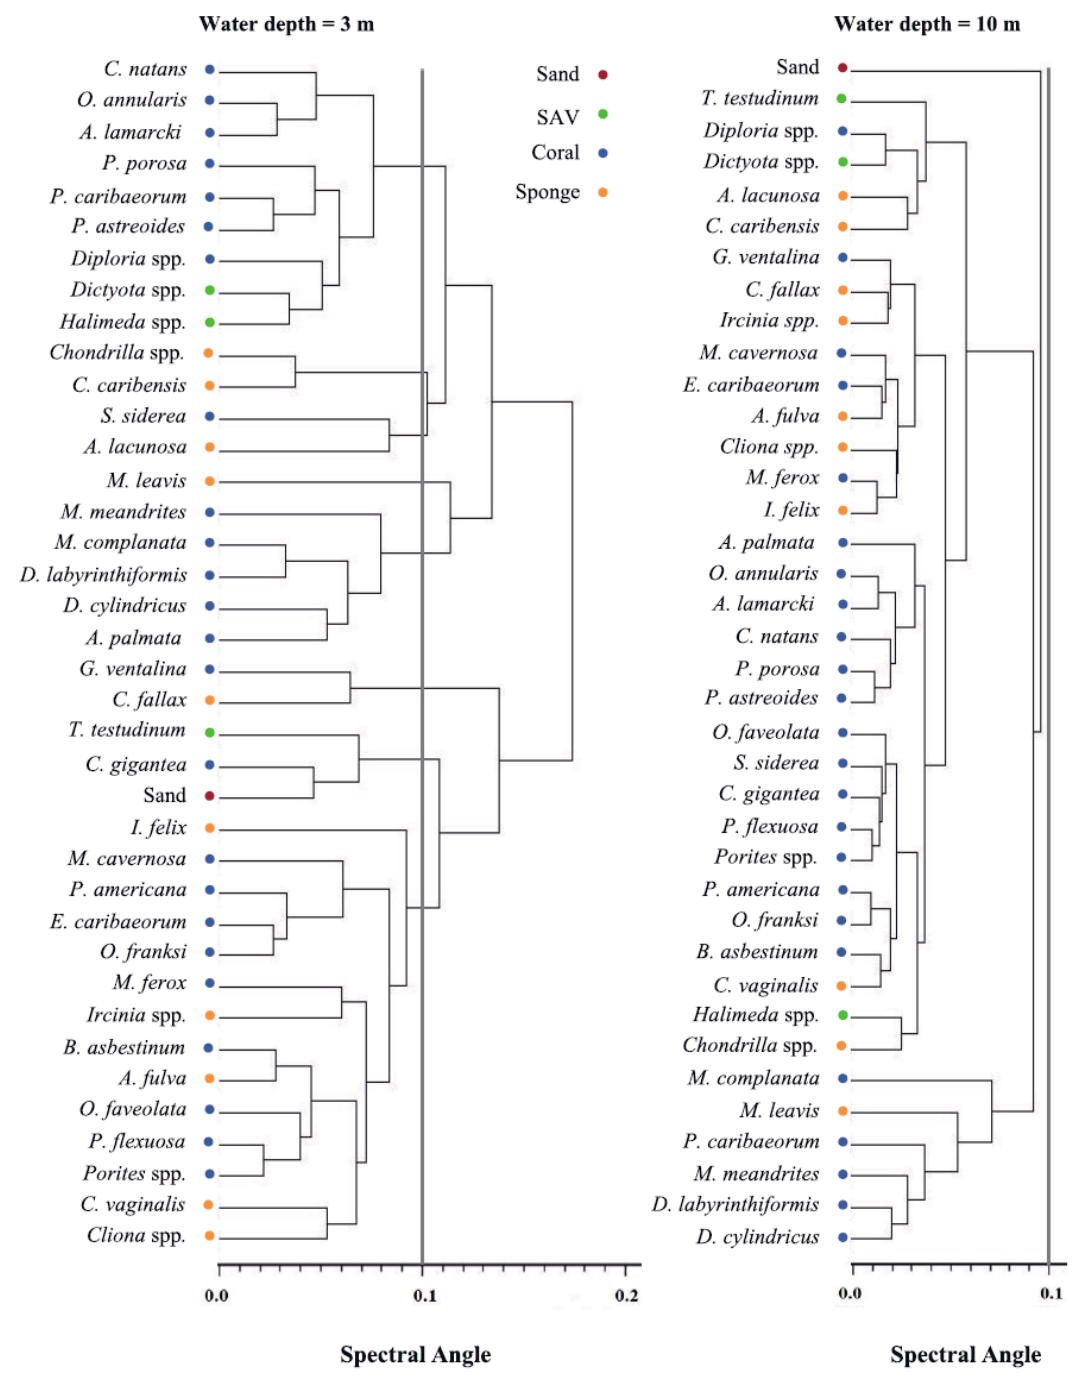
Figure 7. Optical dendrograms for 3 and 10 m water depth illustrating the effects of increasing depth on separability of field spectra from 24 coral species, 10 sponge species, 3 submerged aquatic vegetation (SAV) species, and